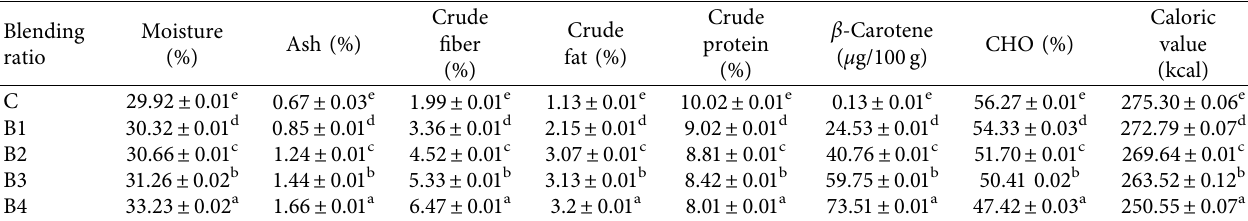
Table 4: Proximate composition of bread produced from wheat, banana, and carrot